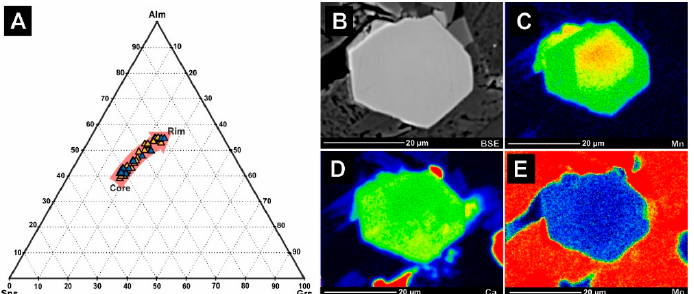
Figure 16. ( A ) Compositional diagram of Grt from the Bôrka Unit Ha č ava blueschist (s. HAC-1): the arrow shows a compositional change in the Grt from the crystal core to the rim. Blue triangles represent analyses from the analytical profile through the garnet crystal (Table 2); and ( B ) the BSE image of Grt used in X-ray element mapping: ( C – E ) Grt X-ray Mn, Ca and Mg element maps. Colour scale: blue–low concentration, red–high concentration. Table 2. Representative analyses of the garnet from the Bôrka Unit. Sample: